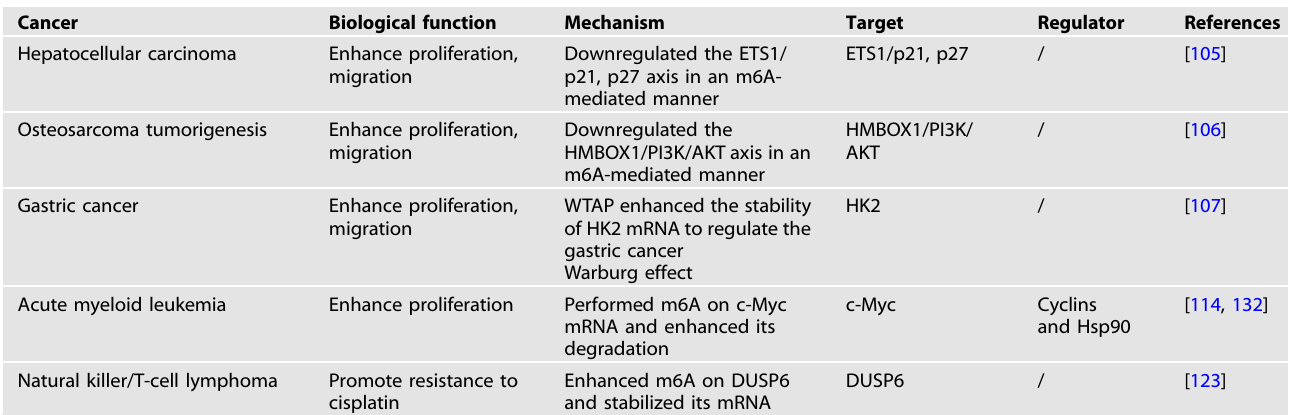
Table 3. WTAP as an m6A methyltransferase in